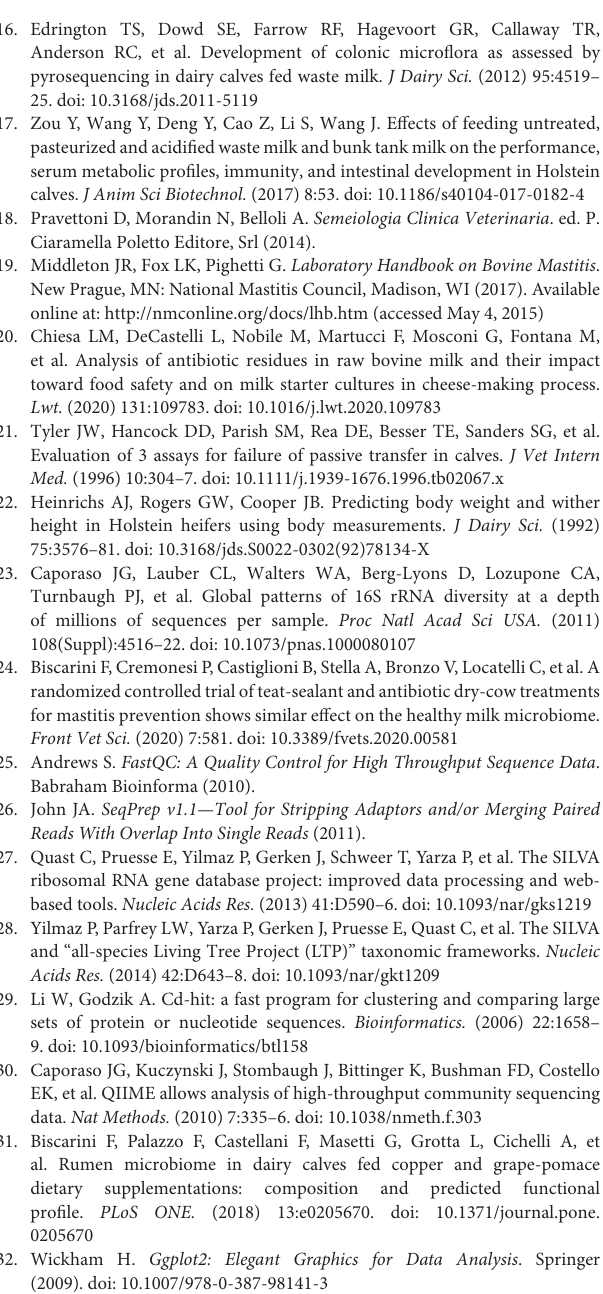
Supplementary Figure 2 | Normalized OTU values observed for all taxa showing statistically significant differences in abundance between WM and BM calves. The results are reported as a heatmap where red indicates the highest and green indicates the lowest normalized OTU value observed for each taxon at the different time points. Supplementary Figure 3 | Statistical significance of the differences in normalized OTU abundances between WM and BM calves reported as a heatmap. Intensity of the red color increases with statistical significance. Supplementary Table 1 | Average number of sequences per treatment and time